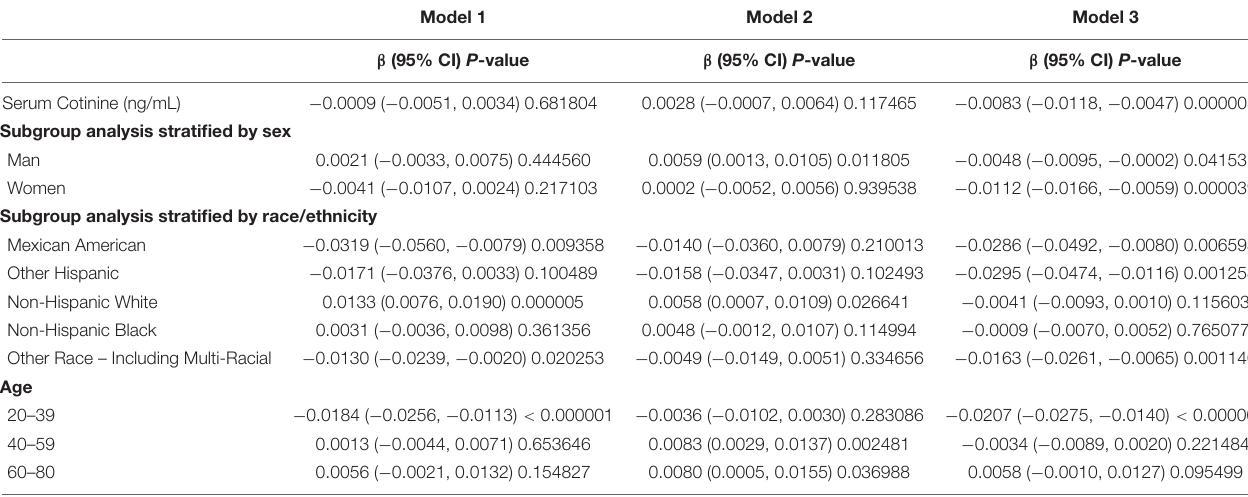
TABLE 2 | The relationship between serum cotinine (ng/mL) and eGFR (mL/min).